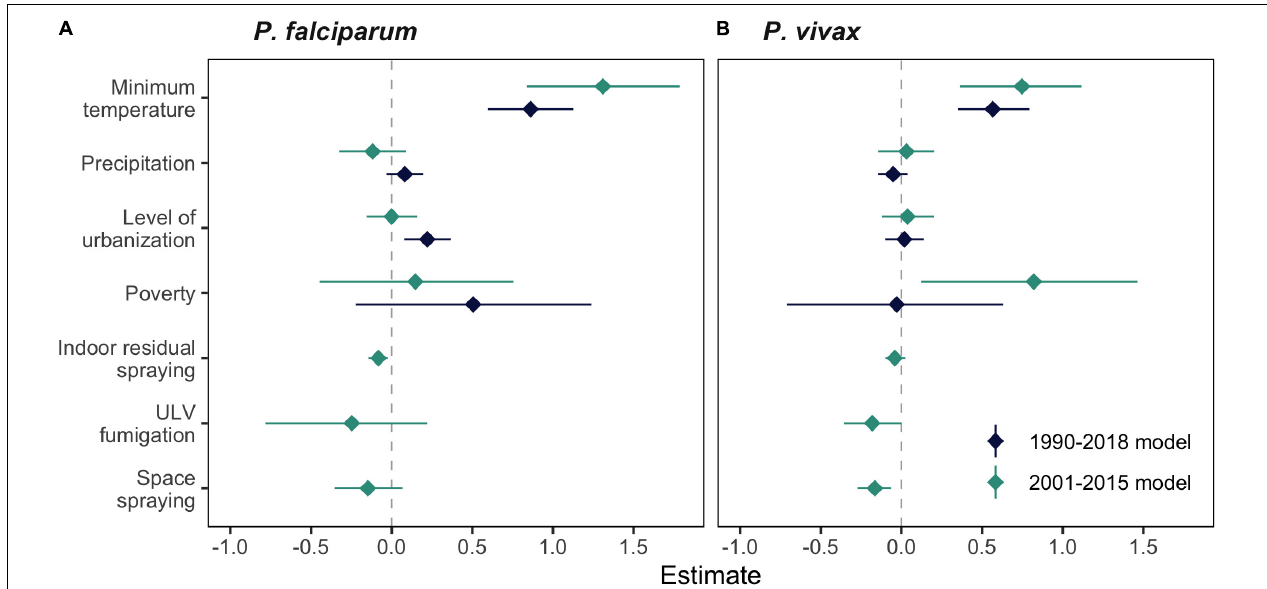
FIGURE 6 | Posterior mean estimates for environmental, socioeconomic and malaria vector control covariates for models of (A) P. falciparum and (B) P. vivax malaria from full models (dark blue) and intervention models (green). All interventions were lagged by 3 months, apart from space spraying in the P. falciparum model, which was lagged by 2